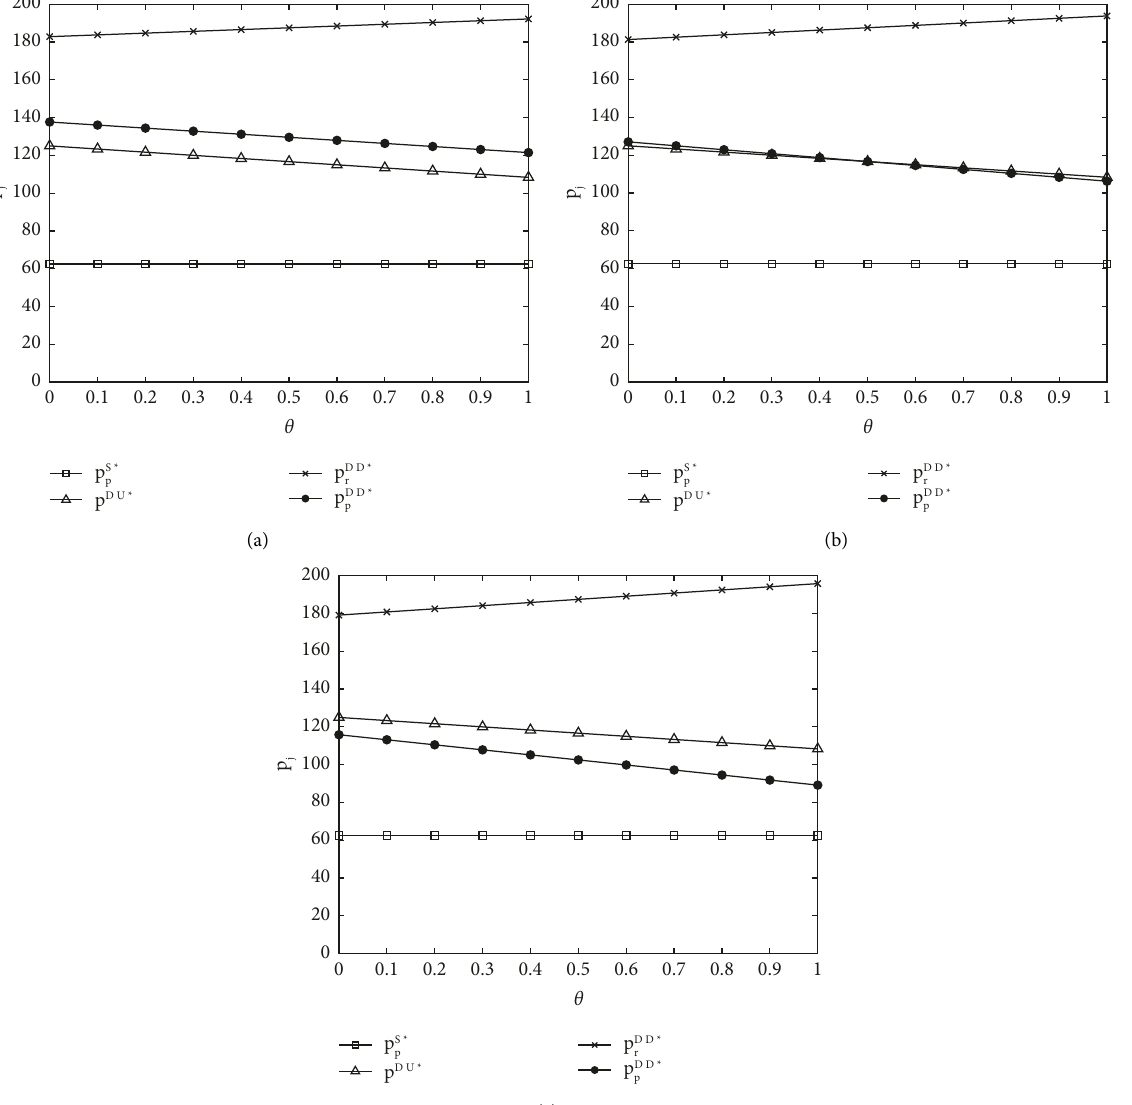
Figure 3: Comparison of optimal recycling prices among three models: (a) b � 0 . 5; (b) b � 0 . 3; (c) b � 0 .